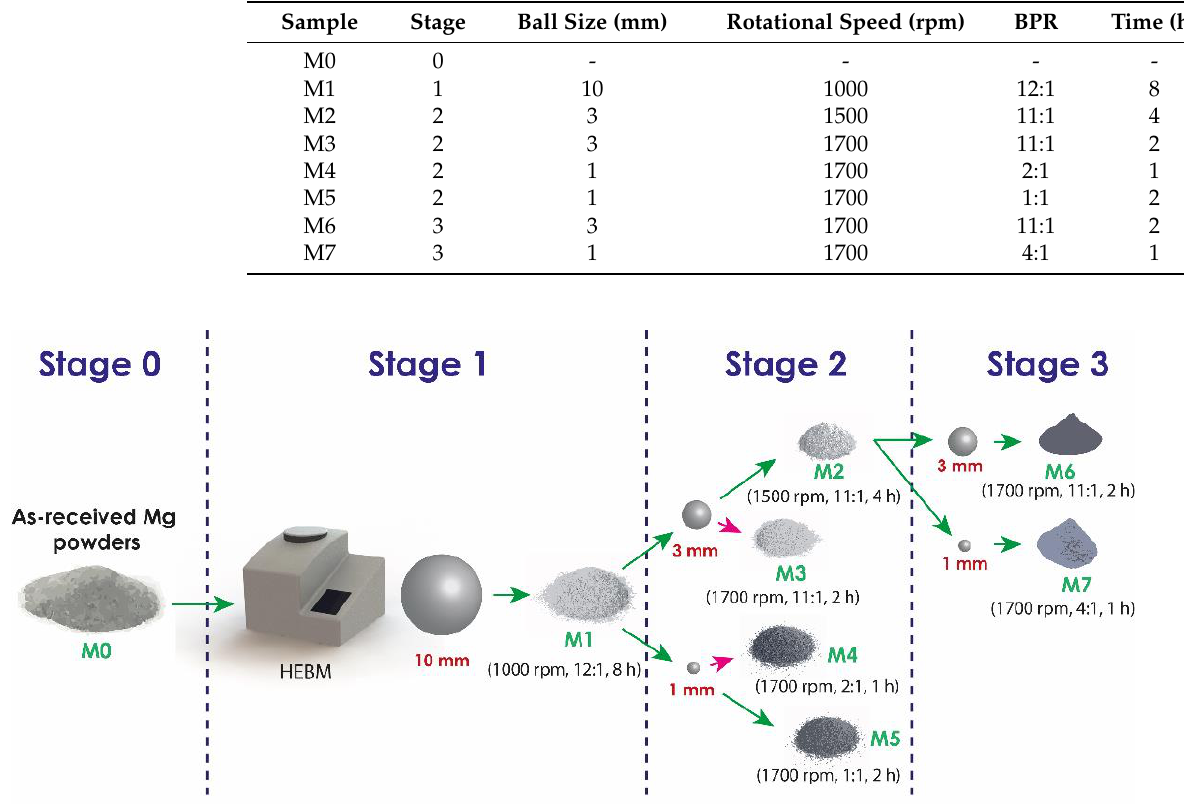
Figure 1. Schematic view of the motion of the balls and powder in a vessel during milling process. Table 1. Pure Mg-milling parameters used during the high-energy ball milling stages.